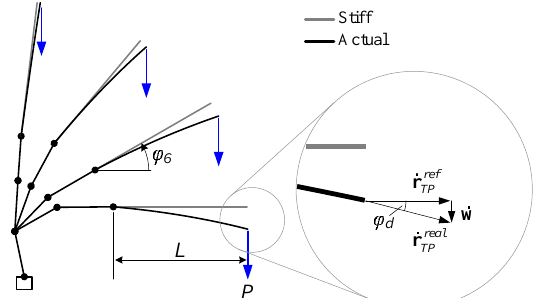
Figure 15: Tool point velocity deviation due to